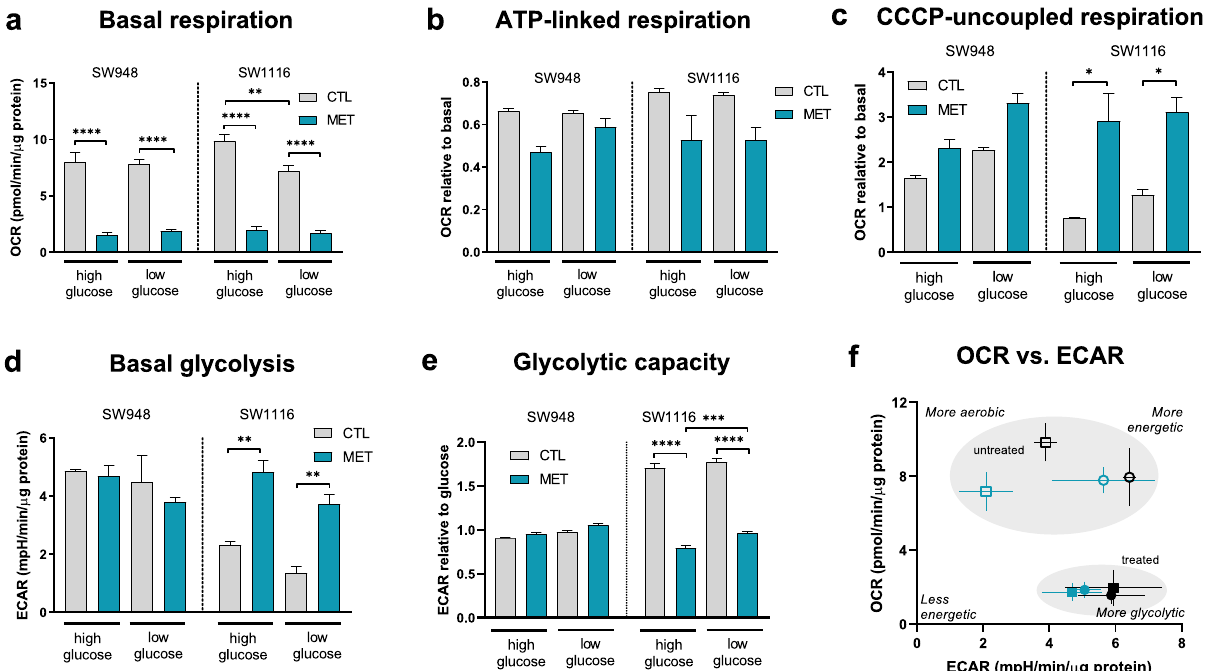
Figure 3. OCR and ECAR were measured in the Seahorse XF96 instrument, with injections of sequential compounds and concentrations according to the assays detailed in the methods section. Mitochondrial stress test assay: ( a ) Basal respiration, before any injections. ( b ) ATP-linked respiration, after oligomycin injection, shown relative to basal OCR level. ( c ) CCCP-uncoupled respiration, shown relative to basal OCR level. Glycolysis stress test assay: ( d ) Basal glycolysis, after glucose injection. ( e ) Glycolytic capacity, after oligomycin injection, shown relative to glycolysis level after glucose injection. Error bars denote s.e.m. Statistical analysis was performed using one-way ANOVA in GraphPad Prism (*p < 0.05; **p < 0.01; ***p < 0.001; ****p < 0.0001) (N = 2–8) ( f ) OCR vs ECAR from the mitochondrial stress test assay. Squares: SW1116; Circles: SW948. Metabolic phenotypes of untreated (open symbols square, circle: control) and treated (closed symbols circle, square: 3 mM metformin) samples. Black: high glucose (25 mmol/L); Teal: low glucose (5 mmol/L). Error bars denote s.d. OCR Oxygen concentration rate, ECAR extracellular acidification rate, CTL control 0 mM metformin, MET metformin 3 mM pre-treatment for